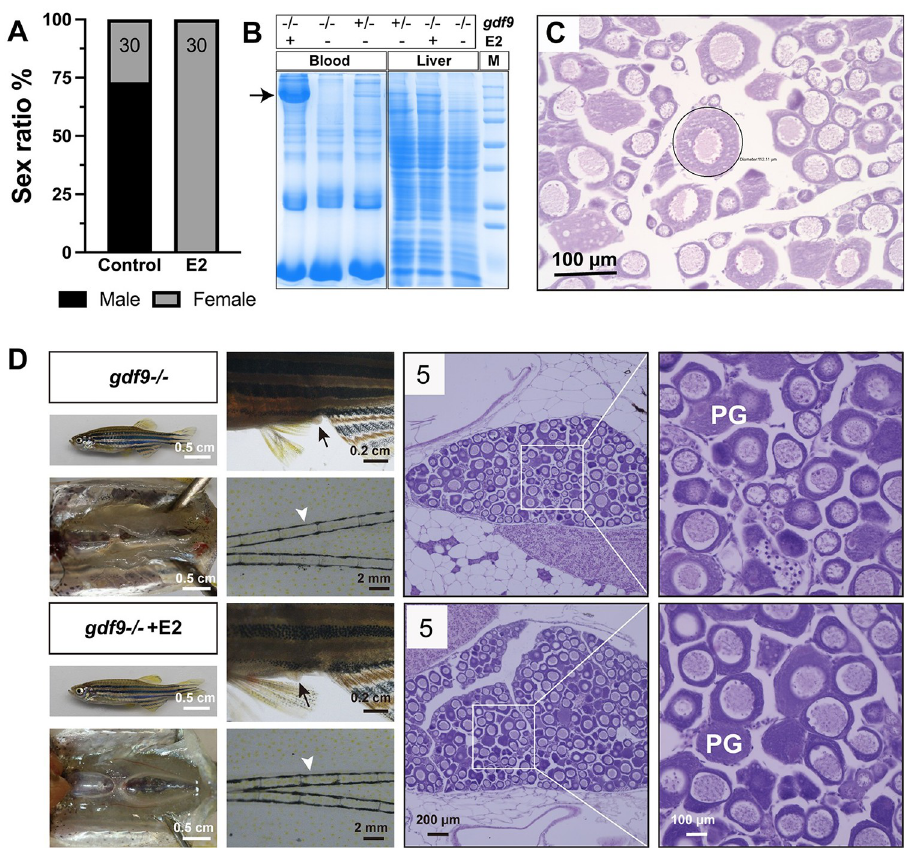
Fig 6. Estrogen treatment of gdf9 mutant. (A-C) Treatment with estradiol (E2) by water-borne exposure. The mutant fish (30/group) were treated from 40 to 60 dpf with E2 (10 nM). E2 treatment resulted in all-female phenotype in contrast to untreated group which showed a male-biased sex ratio (A). Electrophoresis of the sera (1 μ l/lane) from treated mutant females showed mass production of vitellogenin protein (arrow); in contrast, there was no vitellogenin in the sera of untreated mutant fish (-/-). The control fish (+/-) without E2 treatment showed a weak band at the location of vitellogenin. A similar band could also be seen in the liver extract (10 μ g/lane) in response to E2 treatment. Each lane represents one representative individual, and the serum and liver samples were obtained from the same individual for each genotype and treatment combination (B). Histology of the ovary from E2-treated fish showed arrest of follicles at PG stage with a few follicles (circled) showing rudiment cortical alveoli in some individuals (C). (D) Treatment with E2 by oral administration (feeding). The mutant fish were fed with E2-containing diet (20 μ g/g) for 17 days (45–62 dpf) followed by examination for secondary sex characteristics (genital papilla in females, arrow; breeding tubercles in males, arrowhead) and gonadal histology. The treated group showed higher female ratio (44% females, 8/ 18) compared to the control group (21% females, 3/14). Females from both groups showed normal genital papilla with no breeding tubercles and arrested PG follicles in the ovary. The number in each histological photo indicates the number of fish examined with the same phenotype. PG, primary